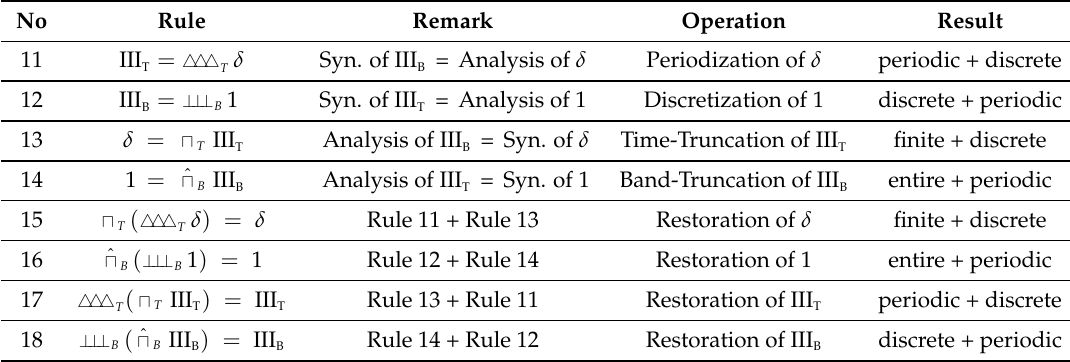
Table A2. Dirac Comb—Synthesis & Analysis.